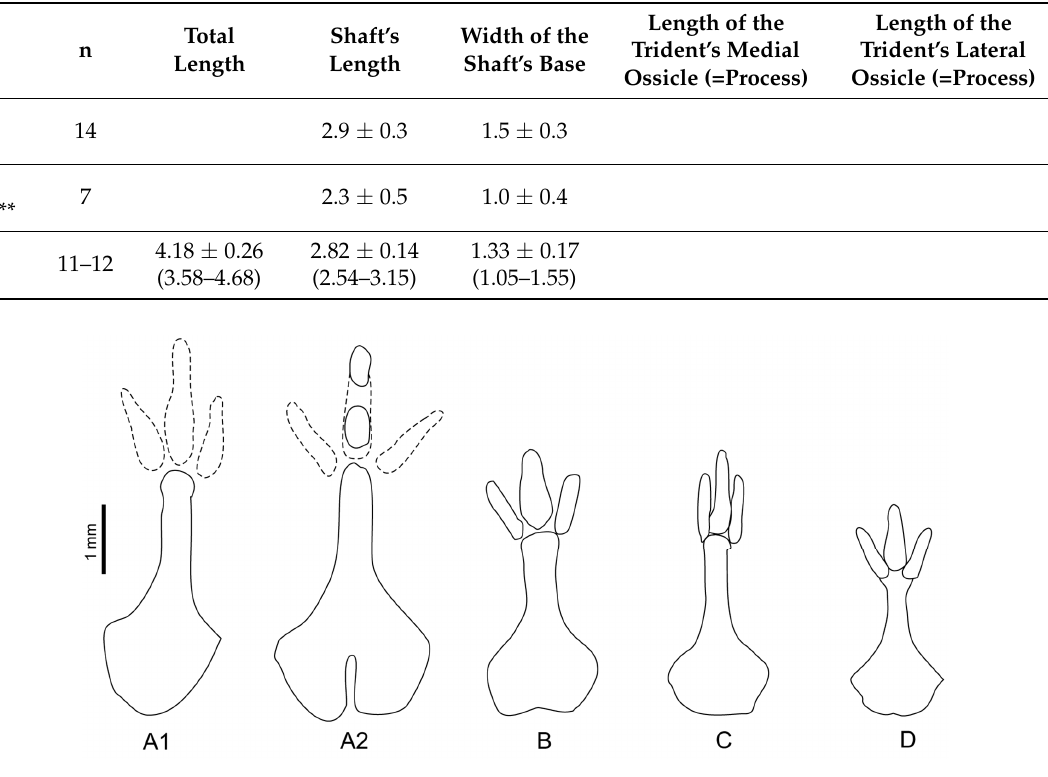
Figure 6. M. hartingi bacula. A : M. hartingi from the Eastern Rhodopes ( A1 : ZIN 107168-47, A2 : ZIN 107168-26), B : M. h. strandzensis [17], C : M. h. lydius [18], and D : M. h. ankaraensis [19]. Table 3. Bacular measurements (mm) in M. hartingi . The number of samples (n), range (r), mean (m), and standard deviation (±SD) (* [17]; ** [2]; *** [18]).